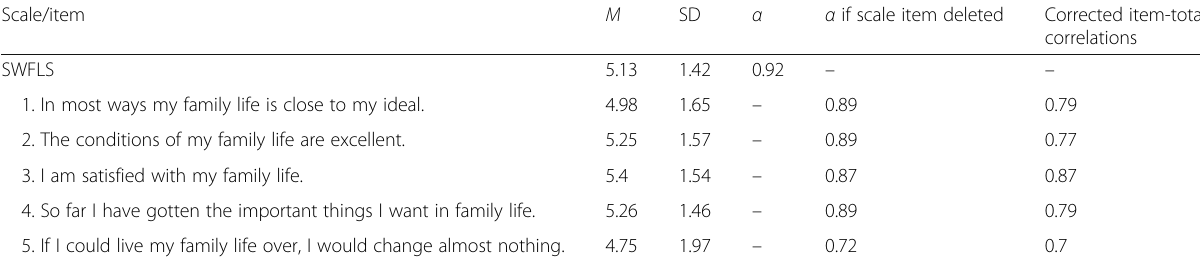
Table 2 Psychometric properties of the Portuguese version of the Satisfaction with Family Life Scale